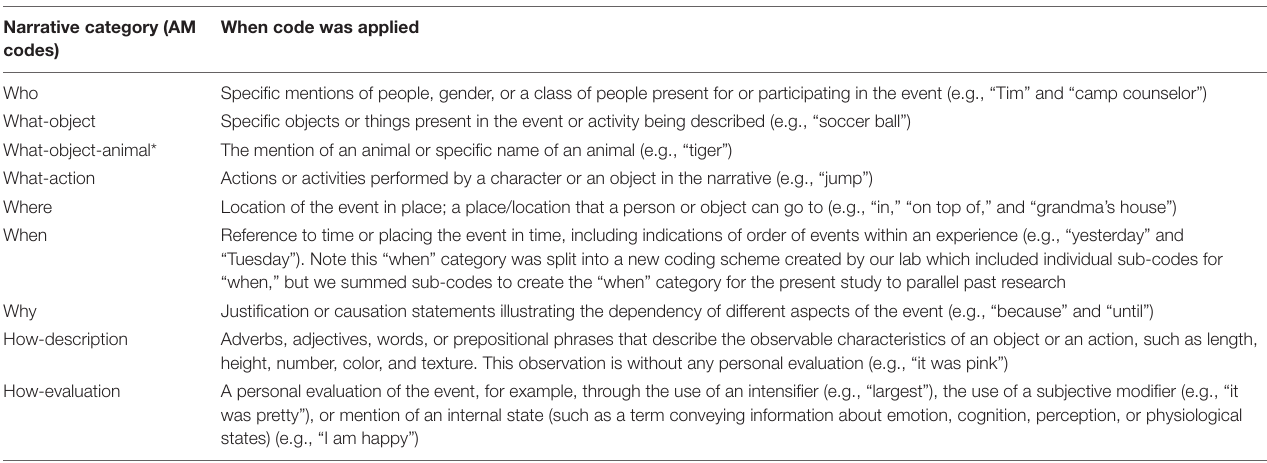
TABLE 2 | Autobiographical memory coding scheme for narrative breadth (children’s descriptions about events).